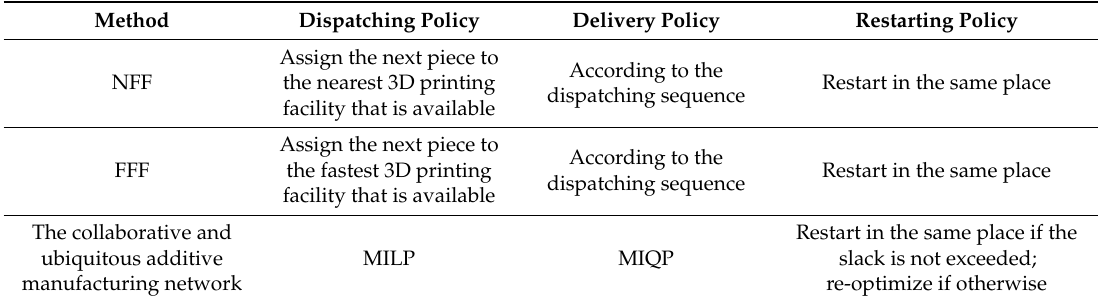
Table 11. Policies of various methods.